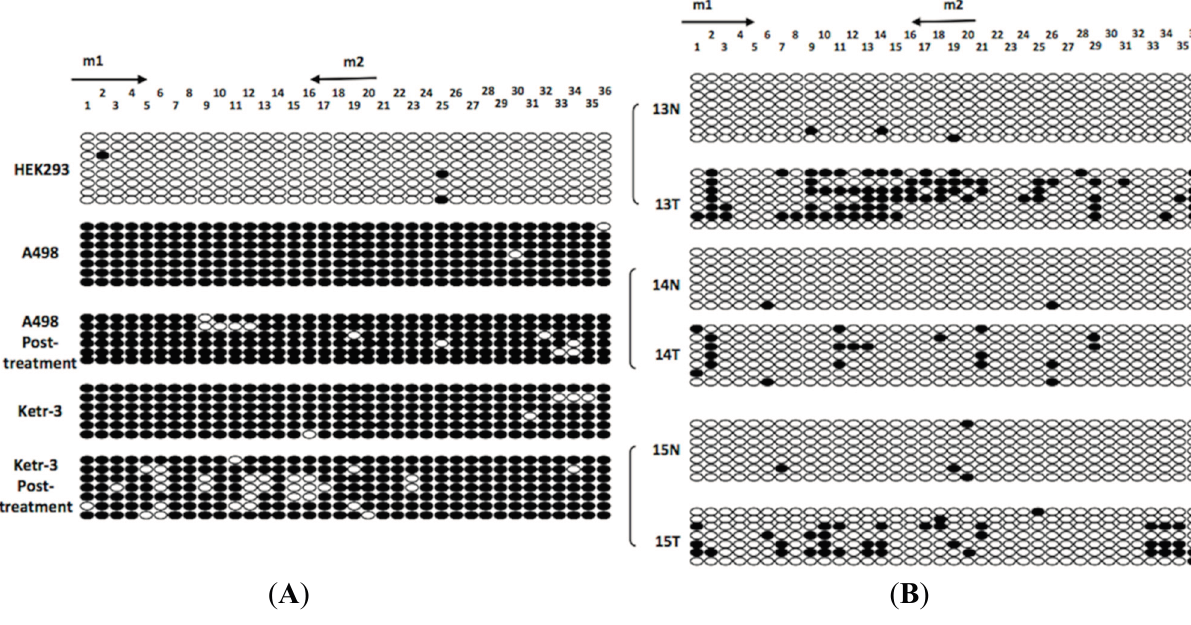
Figure 4. BGS high-resolution mapping of the methylation status of each CpG site (ovals) in the ADAMTS18 gene promoter region. ( A ) BGS results for the HEK293, A498 and Ketr-3 cell lines; and ( B ) BGS results for the ccRCC primary tumors (T) and adjacent normal tissues (N). The rows represent the individual alleles of the ADAMTS18 gene promoter that were analyzed. The arrows indicate MSP primer sites. The black circles indicate methylated sites, while the white circles indicate unmethylated